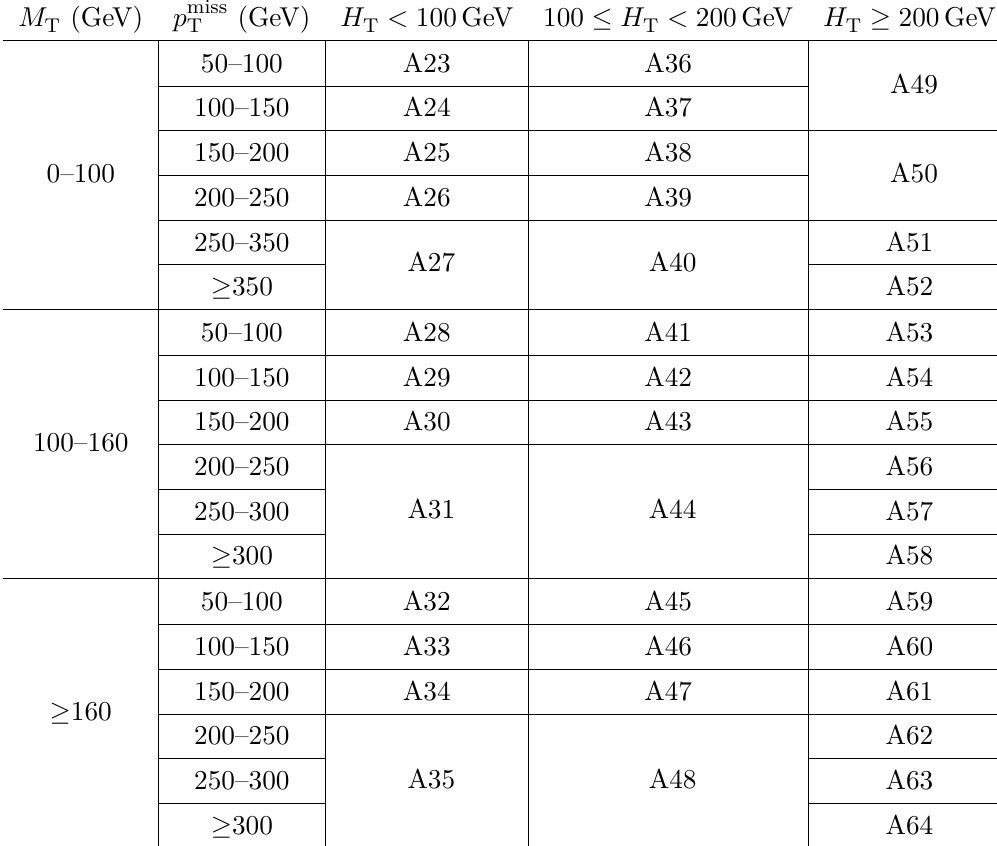
Table 4 . Definition of the search regions used for events with three light leptons, at least two of which form an OSSF pair, and which satisfy 75 < M